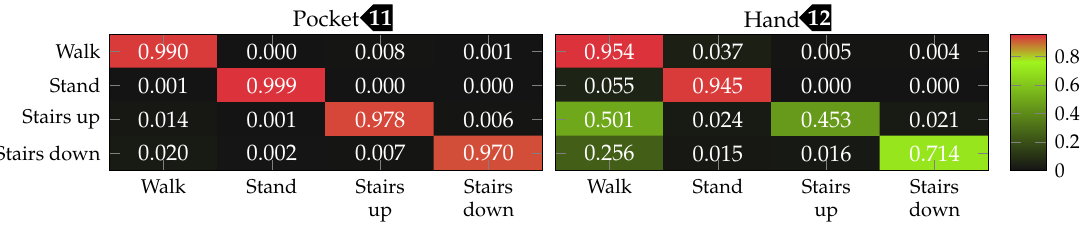
Figure 20. Final confusion matrices for the best-performing configuration ( σ = 0.25, |C| = 32, w sub = 32) of the approach based on codebooks for both pocket-case and hand-case using an SVM classifier. Each row represents the actual class, and each column represents the classification